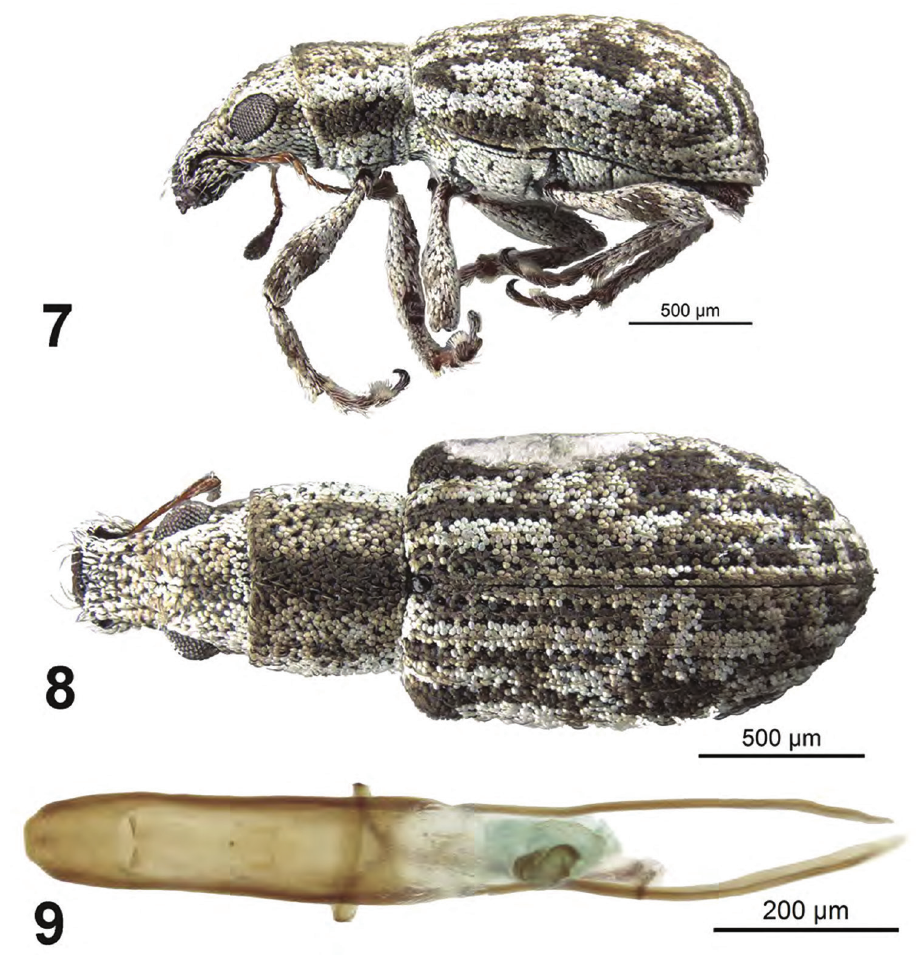
Figures 7–9. Apodrosus beckeli. 7 Lateral habitus, male 8 Dorsal habitus, male 9 Male aedeagus, dorsal.